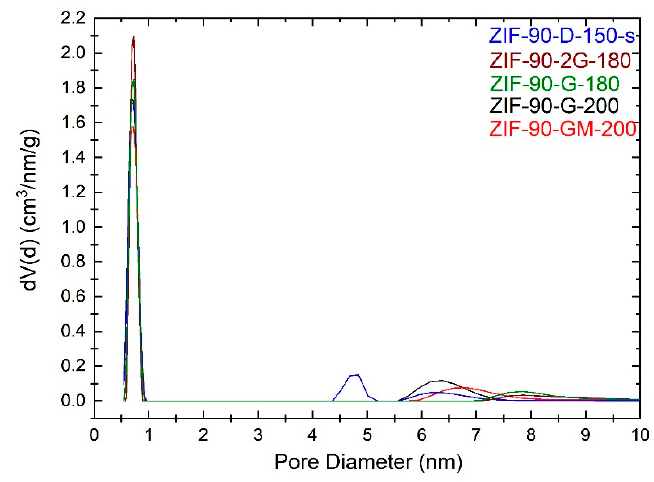
Figure 6. Pore size distribution graph calculated from nitrogen physisorption isotherms.